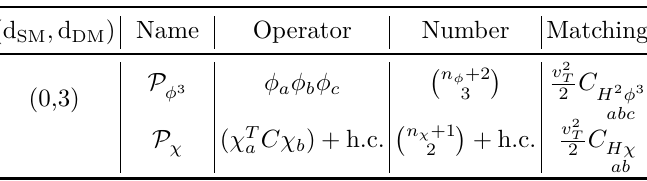
Table 4 . Dimension-three purely DM operators present in DSMEFT and DLEFT. The first column gives the dimensions of the SM and DM part of the operator, the fourth column is the number of operators, and the fifth column is the additional matching contribution at the EW scale. P χ mass